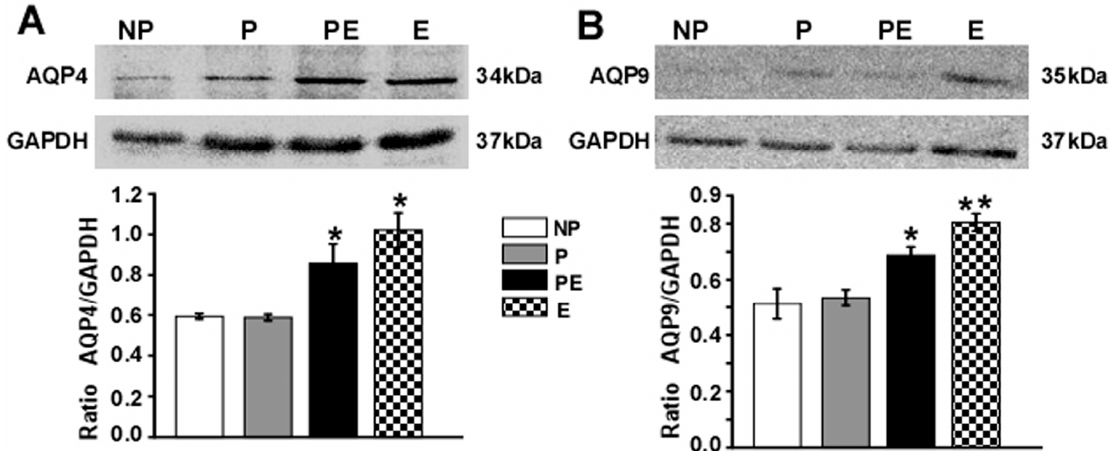
Figure 4. Changes in expressions of AQP4 and AQP9 in the hippocampus after eclampsia ( n = 6). GAPDH (glyceraldehyde-3-phosphate dehydrogenase) was a reference protein. ( A ) AQP4 in the PE and E groups increased significantly compared with that of the NP and P groups (* p < 0.05); ( B ) AQP9 in the PE and E groups increased significantly compared with that of the NP and P groups (* p < 0.05). The E group had greater upregulation of AQP9 compared to the PE group (** p < 0.05).